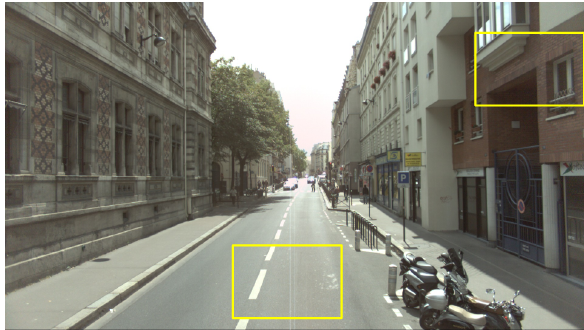
Figure 2. The interest points in the yellow rectangles are selected to show the difference from different extraction methods. Figure 3 demonstrates the interest points on road and facades. The grid based methods enable to find more points in the non- central regions of the images. The close-up patches are shown as the rectangles in figure